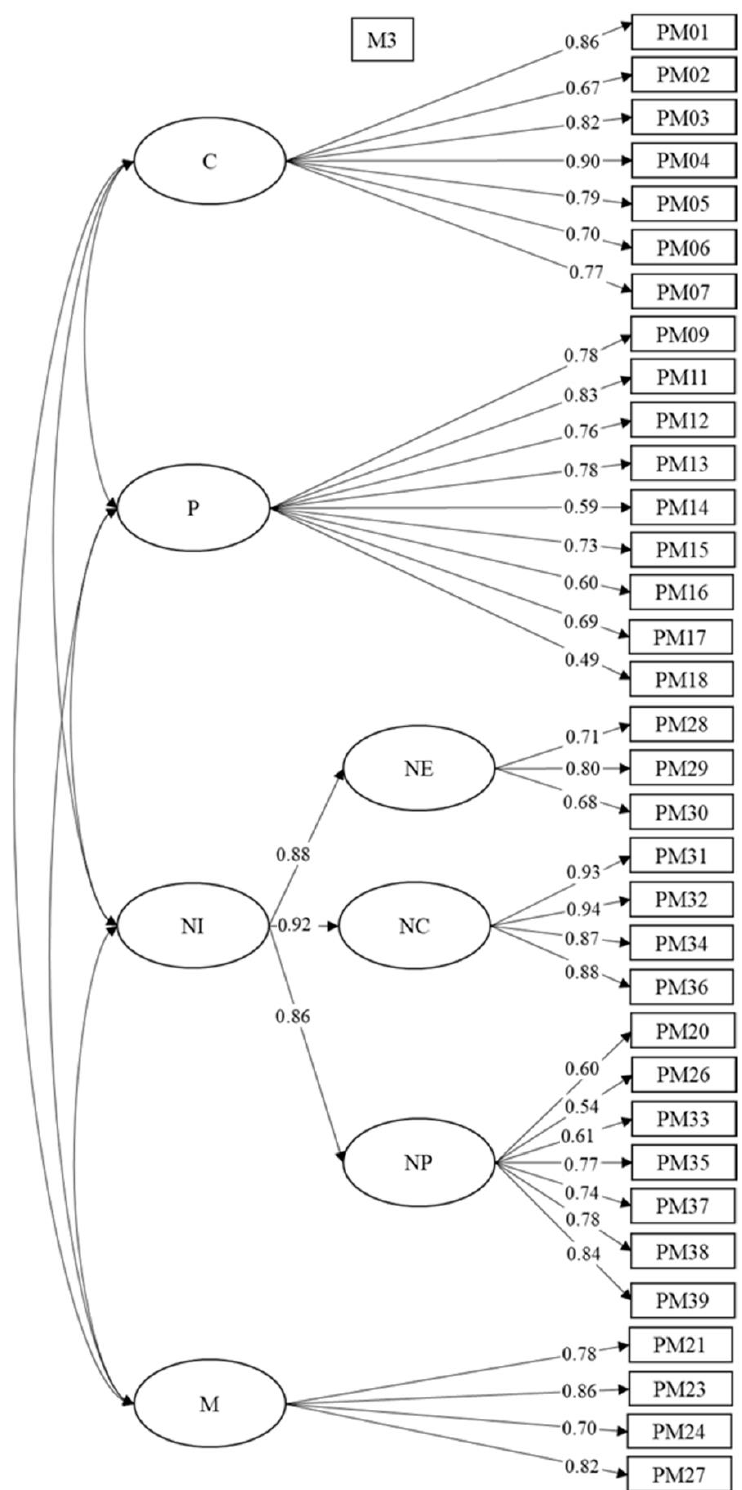
Figure 1. Factorial weights of the items in the hierarchical-oblique model (M3). S, scientistic; P, positivistic; N, negativistic; EN, emotional negativistic; BN, behavioral negativistic; CN, cognitive negativistic; M, myths.